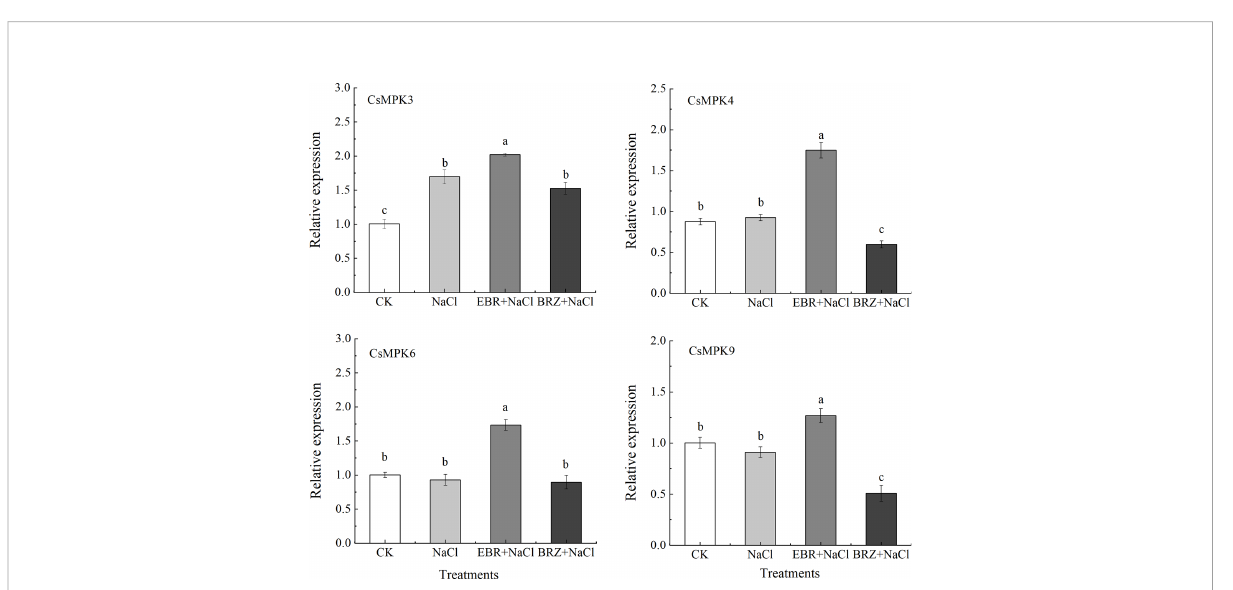
FIGURE 8 Effect of exogenous EBR on the relative expression of CsMAPK3 , CsMAPK4 , CsMAPK6 , and CsMAPK9 genes in the MAPK cascade pathway of cucumber seedlings under salt stress. With CsActin as the internal parameter, the relative expression was calculated by 2 - DD Ct method, and value represents mean ± SE of the three biological replications. different letters indicate signi fi cant differences at P < 0.05 according to Duncan ’ s multiple range